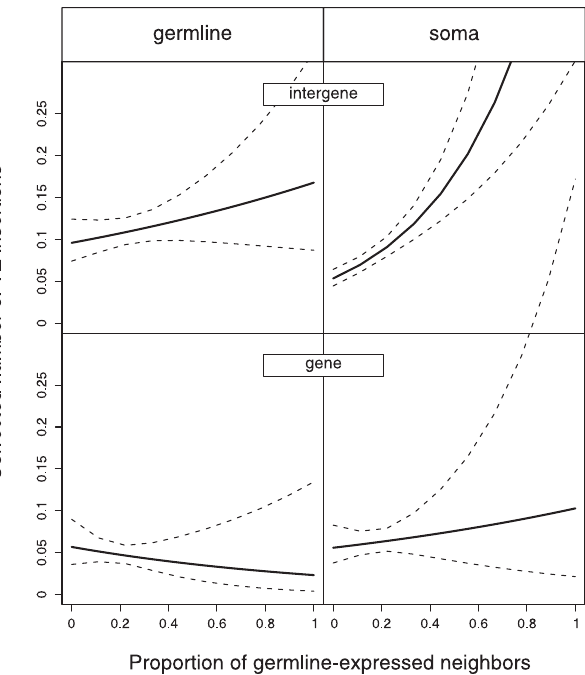
Figure 3. Length of Intergenic Regions and Introns þ UTRs as a Function of the Proportion of Germline-Expressed Neighbors The figure represents the coefficients ( 6 95% confidence intervals) of a log-gaussian GLM analysis of noncoding length of genes/length of intergenic regions as a function of the factors tissue of expression (germline versus soma), element (gene versus intergenic), and neighbor- hood (proportion of germline-expressed genes among the ten neigh- bors). The figure illustrates that the effect of the genomic neighborhood depends both on the identity of the genomic element (gene versus intergenic region) as well as the expression type, a fact reflected in the significant triple interaction term in the GLM ( F ¼ 4.19, p , 0.05).